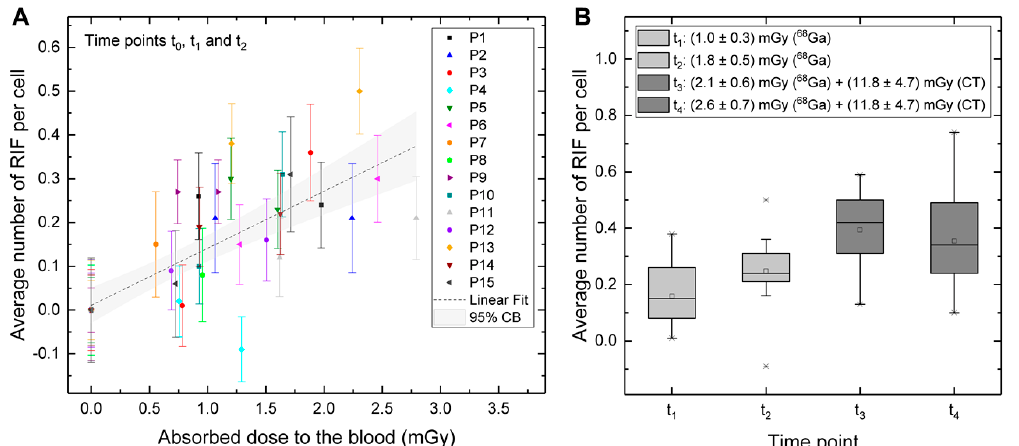
Figure 2. In vivo study—time-dependency of the average number of foci and radiation induced foci (RIF). ( A ) Boxplot of the average number of foci per cell at the five sampling time points t 0 to t 4 . The mean of the average number of foci at the time points t 1 , t 2 , t 3 , and t 4 is significantly elevated compared to the mean baseline value at t 0 . A significant increase of the average number of foci was also observed from t 1 to t 2 and from t 2 and t 3 . ( B ) Patient-specific average number of RIF per cell as a function of the time after administration.